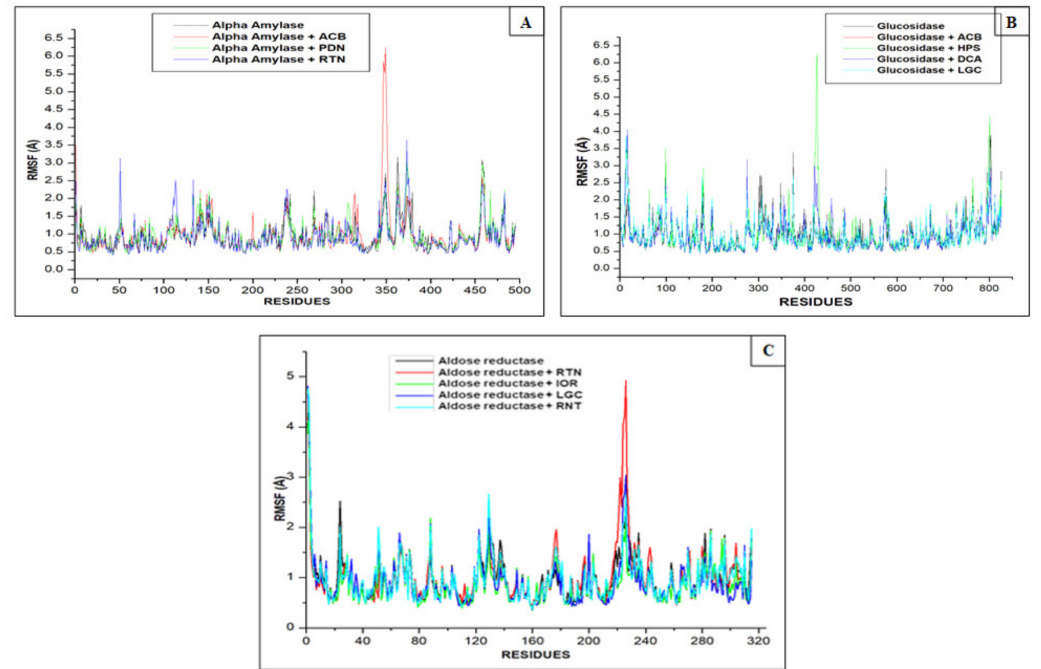
Figure 4. Comparative plots of α -carbon of ( A ) alpha-amylase, ( B ) alpha-glucosidase and ( C ) aldose reductase and phenolic compounds and standard molecules (acarbose, ranirestat) presented as RMSF and determined over 100 ns molecular dynamics simulations. ACB: Acarbose; RNT: Ranirestat; PDN: Procyanidin; RTN: Rutin; HPS: Hyperoside; DCA: 1,3- Dicaffeoxyl quinic acid; IOR: Isohamnetin-3- O -rutinoside; LGC: Luteolin7- O -beta- D